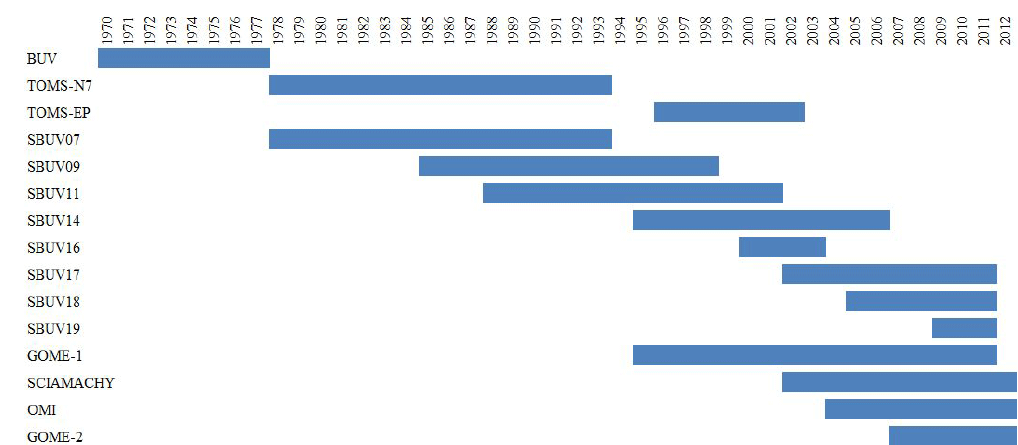
Figure 1. Data availability for each satellite instrument used in the ozone